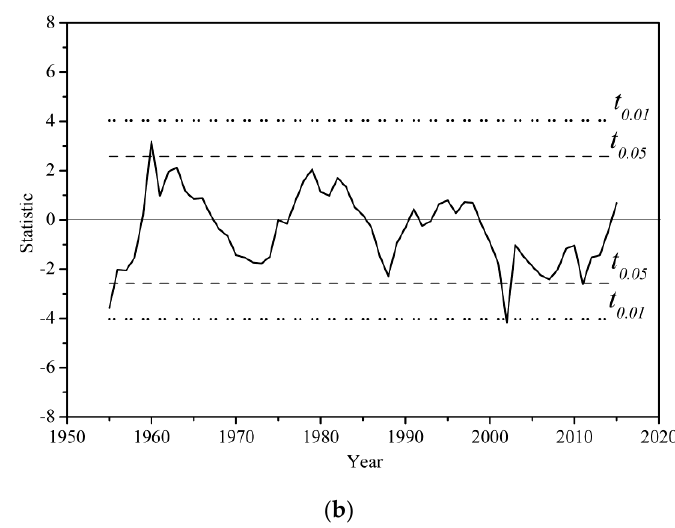
Figure 5. ( a ) Mean annual temperature M – K statistic curve. ( b ) Mean annual temperature slip t -test statistic curve. α = 0.01 refers to the 99% confidence limit, t 0.01 and t 0.05 refer to the 99% and 95% confidence limit of the slip t -test.